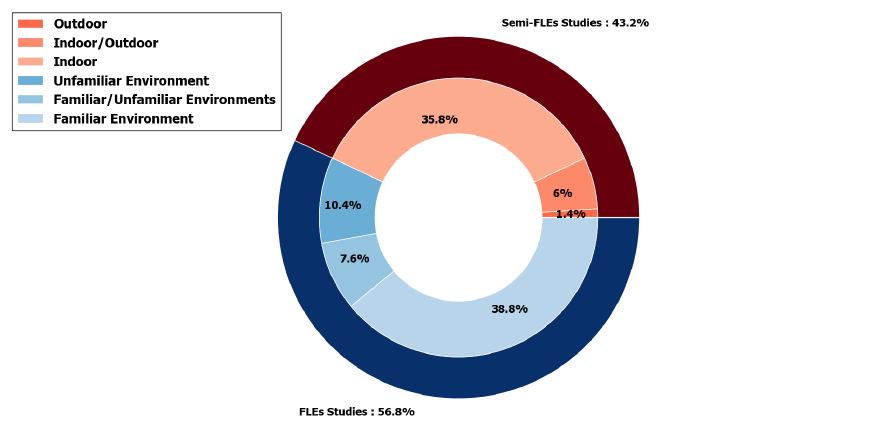
Figure 8. Number of studies focusing on Free-Living Environments (FLEs), semi-Free-Living Environments (Semi-FLEs), or both of them. The proportion of FLEs studies performed in Familiar, Unfamiliar, or both types of environments and the proportion of semi-FLEs studies performed in outdoor, indoor, or both types of locations are also detailed.